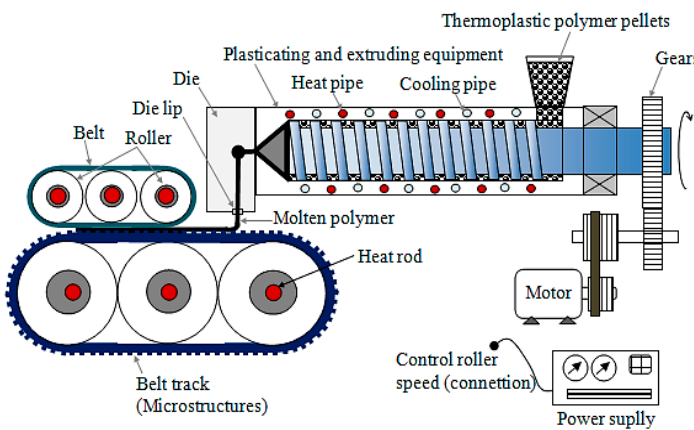
Figure 3. Architecture of belt-type hot roller embossing process technology system.